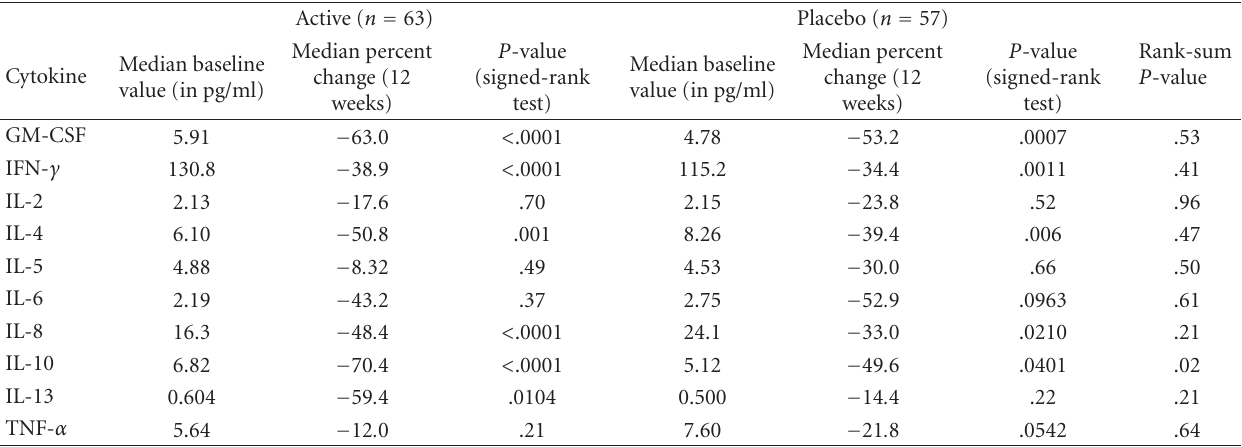
Table 2: Laboratory values.